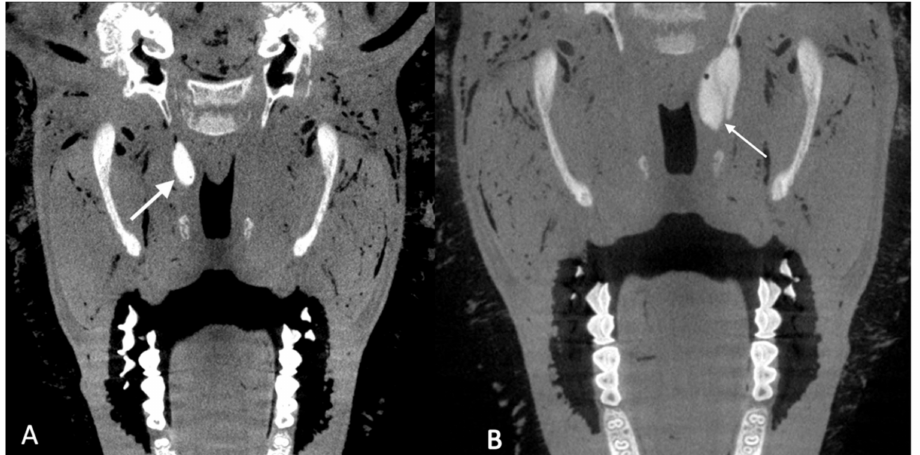
Figure 3. CBCT scans of cadaver heads after injection of 0.3 mL HA ( A ; case 13) or 1 mL HA ( B ; case 19b). The depots (white arrows) were visualized by addition of Imeron ® and were classified as good ( A ) and good with rostral bulge ( B ) (compare Table